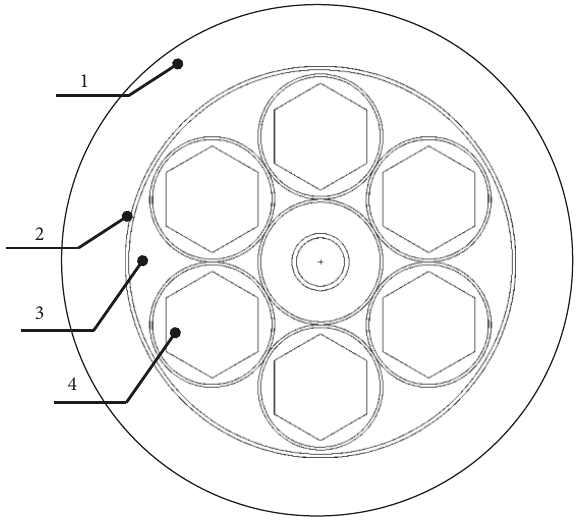
Figure 1: The layout of the fuel assembly in six-place cask for dry